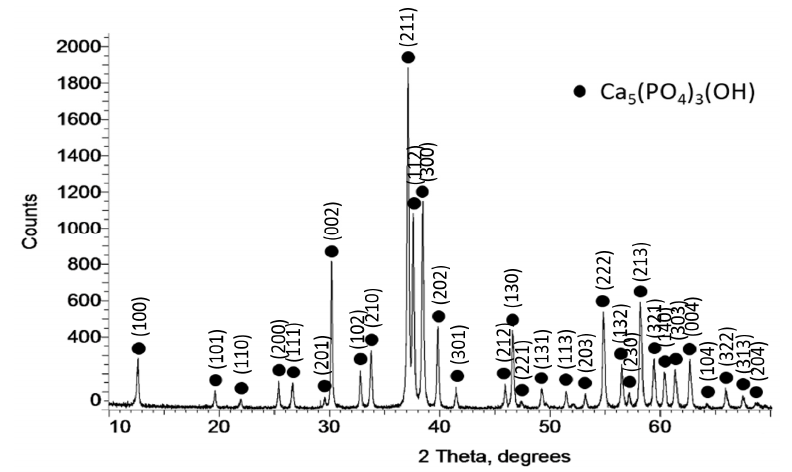
Figure 3. X ‐ ray diffraction pattern of hydroxyapatite (HA) powder. Figure 3. X-ray diffraction pattern of hydroxyapatite (HA) Cross ‐ sections of coatings HA1, HA2, and HA3 are shown in Figure 4a–i, respec ‐ tively, which clearly reveal their lamellar structures. The highly deformed lamellas were characterized by significant internal porosity, which stemmed from the porosity of the HA powder grains. It also resulted, in part, from the significant differentiation of the re ‐ melting of HA powder grains depending on their size and position in the plasma stream. In Figure 4d,e cracks were visible between the lamellas, which may have arisen from re ‐ duced coating cohesion as a result of the shortest spray distance. Figure 4. Microstructures of hydroxyapatite (HA) coatings ta low and high magnification; ( a – c ) HA1, ( d – f ) HA2, ( g – i ) HA3. Arrows: white–cracks, yellow–deformed lamella, red–pores.